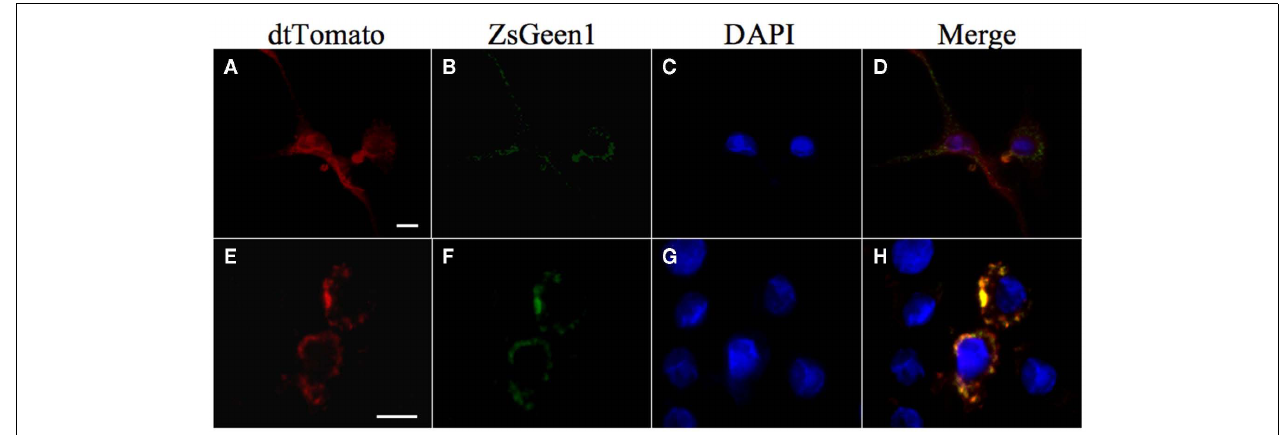
labeled Rv3364c protein is also visible as punctate pattern (E) , whereas dtTomato plane protein is diffused in the cytoplasm of macrophages (A) . Nuclei are stained with DAPI (C,G) .The overlap between cathepsin G and Rv3364c immunoreactivity appears yellow in the merged micrographs indicating colocalization of studied proteins (H) . Scale bar, 10 μ m.